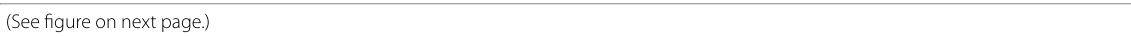
figure on next Fig. 8 As the severity of SAH worsens, neuronal cell death increases in the cerebral cortex in the anterior region of the cerebrum (1.0 mm anterior to bregma). a Cells that were positive for both NeuN and TUNEL were quantified to assess neuronal cell death. The number of dead neural cells in layers I to III of the anterior region of the cerebrum was quantified ( n 3, each group). b Quantification of the number of dead neural cells in layers = IV to VI of the anterior region of the cerebrum ( n 3, each group). c Quantification of the number of dead neural cells in all layers of the anterior = region of the cerebrum ( n 3, each group). d Representative confocal images of TUNEL (green) and NeuN (red) in the anterior cortex. Nuclei were = counterstained with Hoechst (blue). Scale bar, 50 μm. Statistical analyses were performed with one-way ANOVA and Tukey–Kramer post hoc tests. The values in the bar graphs represent the mean SD. ** p < 0.01, *** p < 0.001. NS: not ±